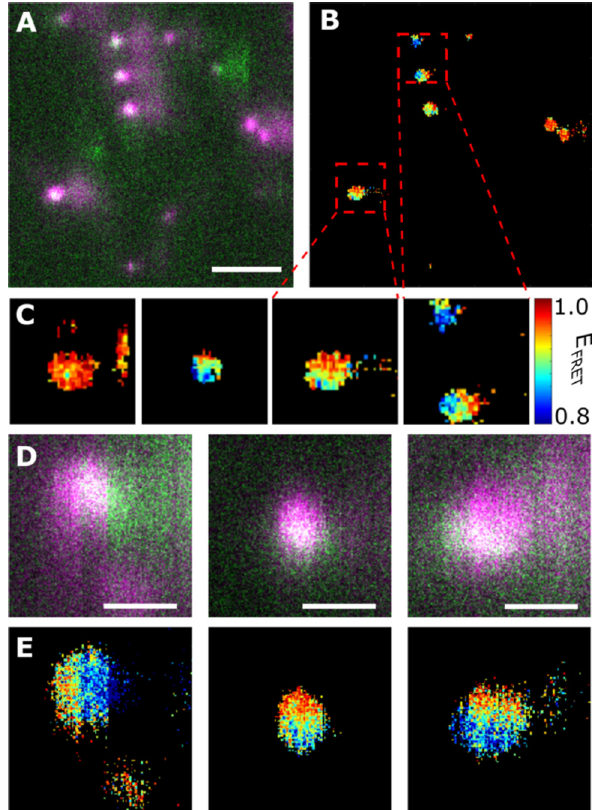
Figure 4: (A) Representative antenna-based image of individual FRET pairs after renormalizing the signal in the donor channel to its maximum. The sample is line-scanned along the vertical direction. Scale bar: 500 nm. (B) Corresponding E FRET map calculated on a pixel-by-pixel basis after applying a 2 × 2 pixel Gaussian fi lter to the original image for better visualization. (C) Zoom-ins of different E FRET spots with a lateral resolution of 8 nm (pixel size). Each spot shows a different spatial E FRET pattern and pixel-to-pixel variations of E FRET are readily observed. (D, E) Individual intensity and E FRET spots respectively, mapped with a lateral resolution of 2 nm (cor- responding to the pixel size). Notice that on the left panel photo- bleaching of the acceptor occurs during scanning so that the donor signal (green) is recovered and FRET is lost, further demonstrating that our measurements are performed at the level of single FRET-pairs. Scale bars: 200 nm. Integration time: 10 ms per